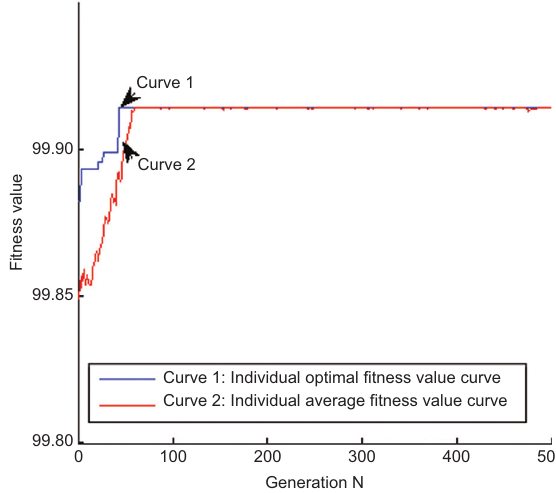
Figure 8. The Convergence Curve when the Population Size is Set to 200.